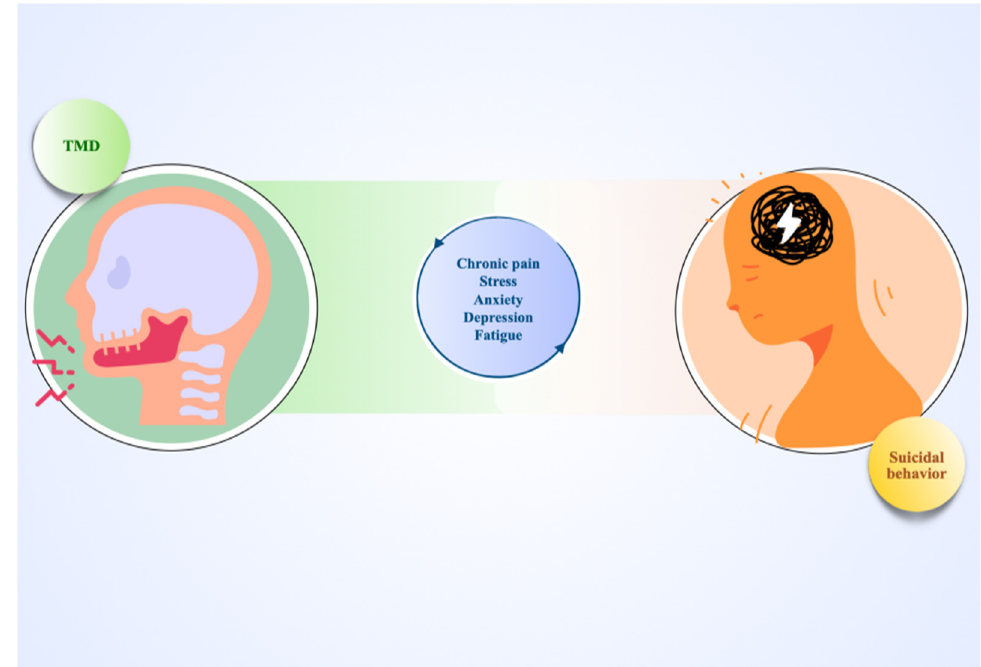
Figure 3. Schematic representation of some possible underlying mechanisms explaining the associa- tion between the presence of temporomandibular disorders (TMD) and suicidal